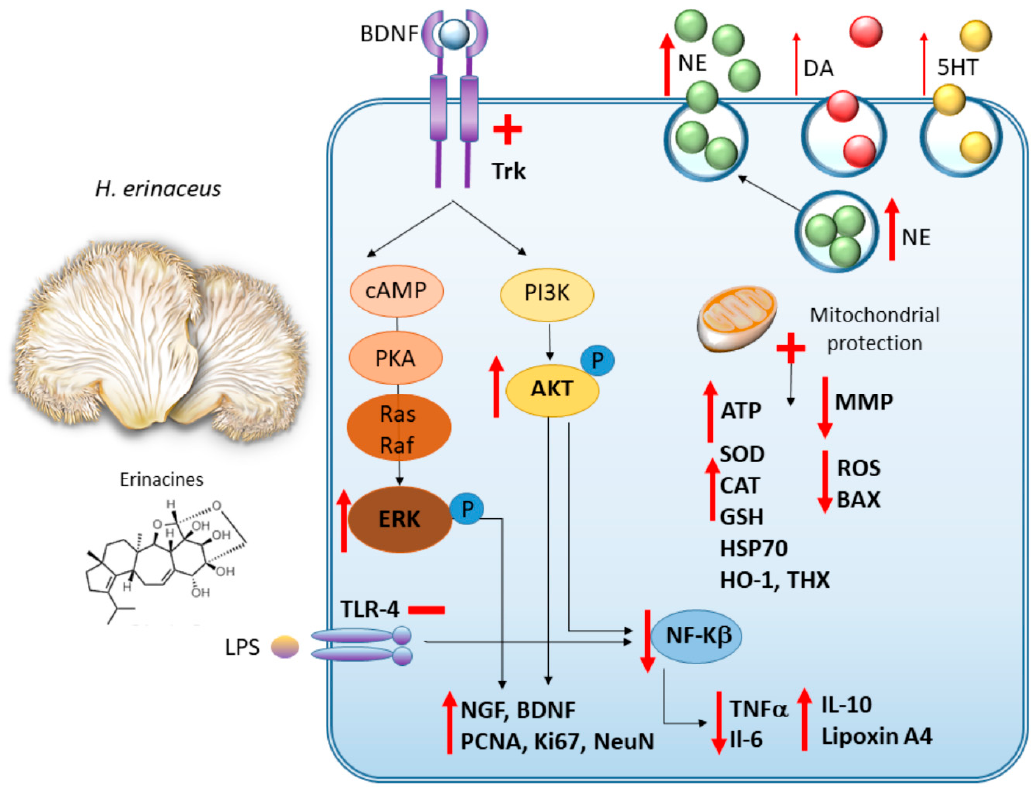
Figure 4. H. erinaceus: molecular mechanisms underlying neuroprotective and antidepressant-like e ff ects. H. erinaceus and its bioactive ingredients (mostly erinacines) potentiate monoamine, and mostly norepinephrine (NE) synthesis and release. At the same time, they promote TrkB-related increase in pERK and pAKT and the subsequent synthesis of neurotrophic factors (BDNF and NGF) along with neurogenesis. H. erinaceus promotes anti-inflammatory e ff ects through inhibition of TLR4 / NF-kb, PI3K / AKT / Nf- κ B axes. H. erinaceus also protects from apoptosis, mitochondrial damage and promotes anti-oxidant e ff